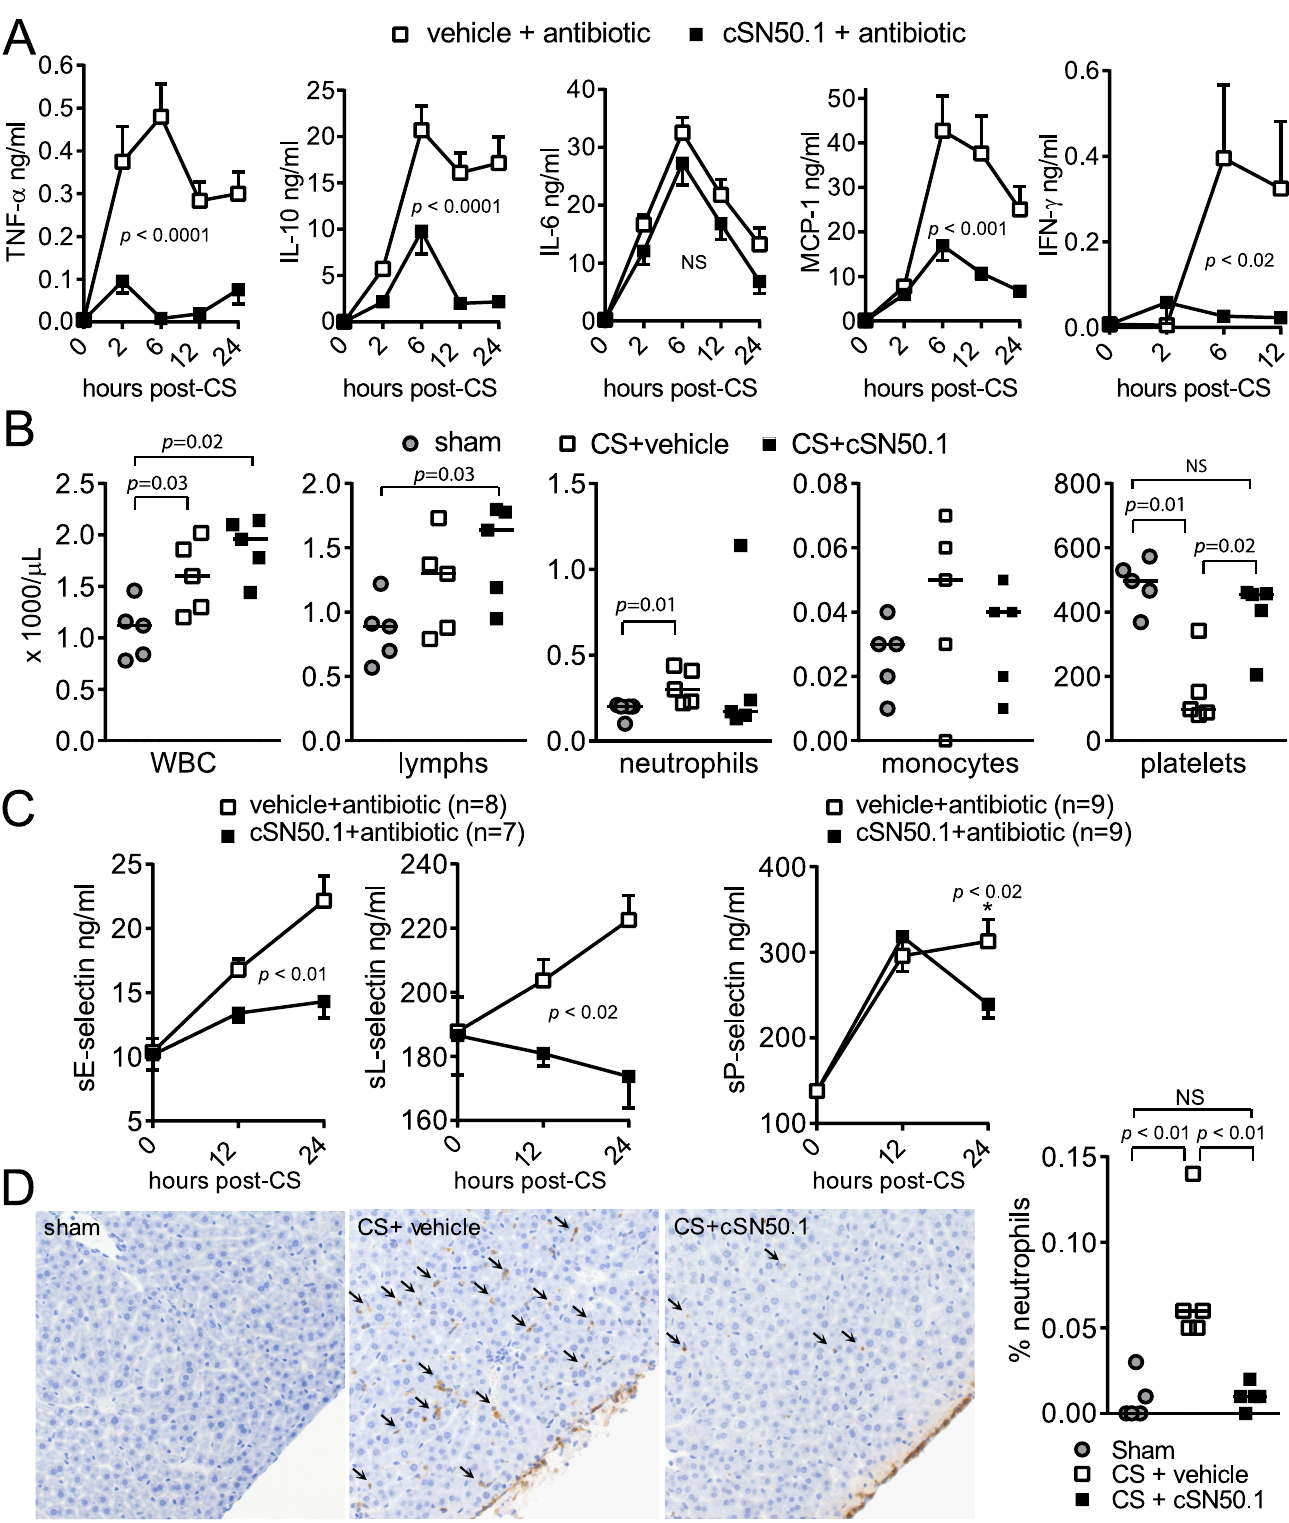
Fig 4. NTM modulates blood and vascularresponses to sepsis. ( A ) Cytokines/chemokine measuredin blood plasma by cytometric bead array before and at 2 h, 6 h, 12 h, and 24 h after CS infection. Antibiotic therapy with meropenem began at 12 h post-infection. ( n = 20 mice/group; p values calculatedby two-way repeatedmeasuresANOVA). IFN- γ measured by ELISA in blood plasma before and at 2 h, 6 h and 12 h after CS infection.